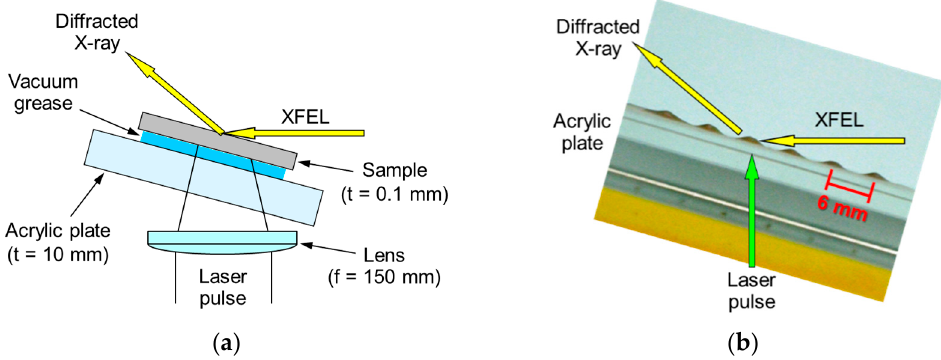
Figure 16. The sample configuration: ( a ) The acrylic plate was placed on the diffractometer with a tilt angle of 16°.; ( b ) A magnified view of the sample foil after pump-probe experiments. Each laser pulse locally deforms the sample, creating a cone with a rounded head.